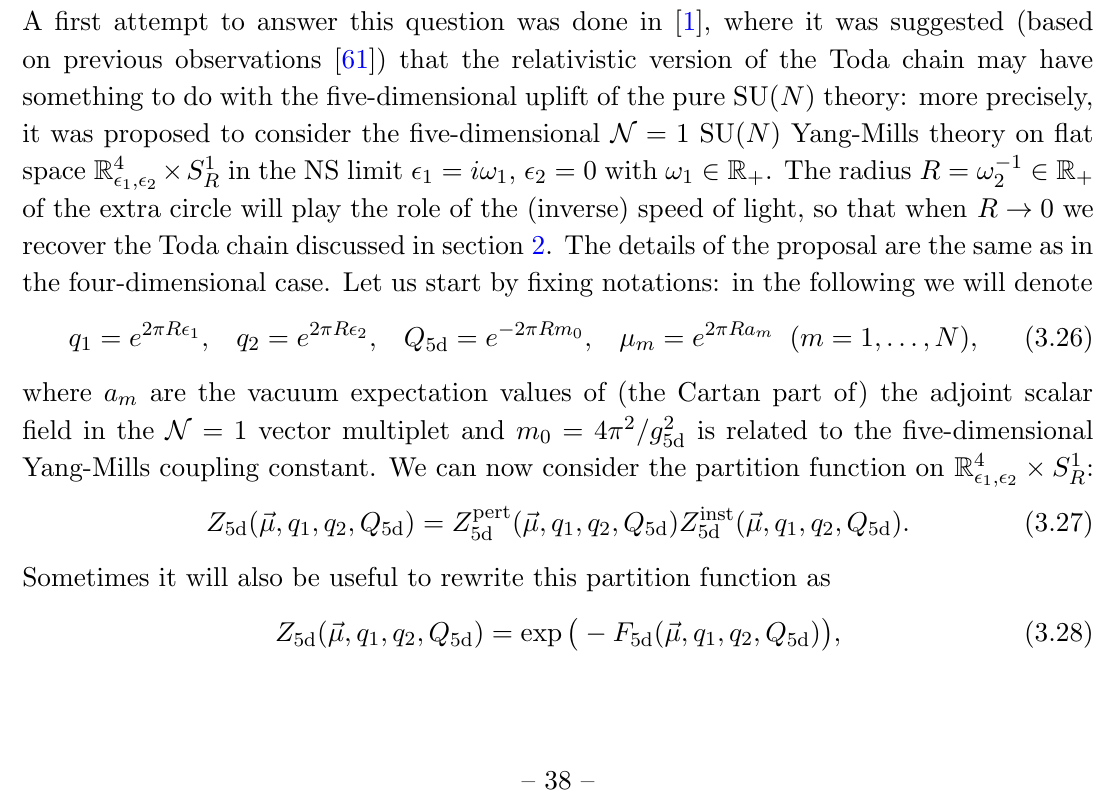
, ! 2 = 1, m 0 = (cid:0) ln3 2 (cid:25) 2